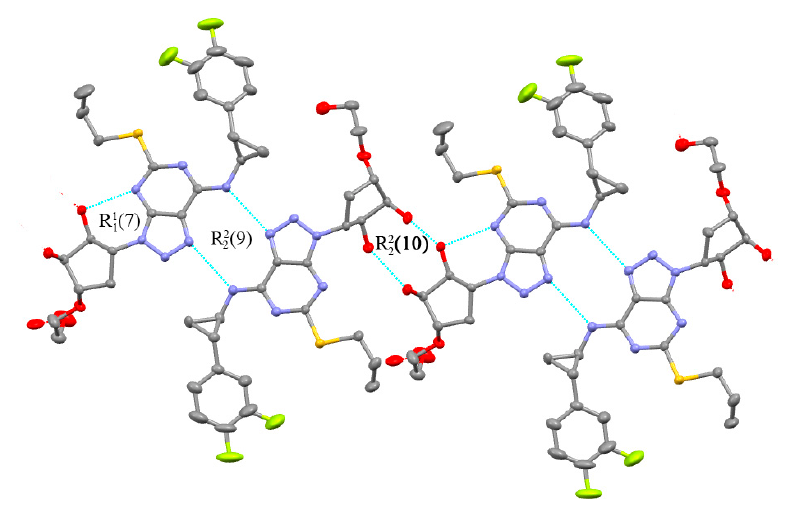
Figure 3. The molecule structure of TICA-II, showing displacement ellipsoids at the 50% probability level.